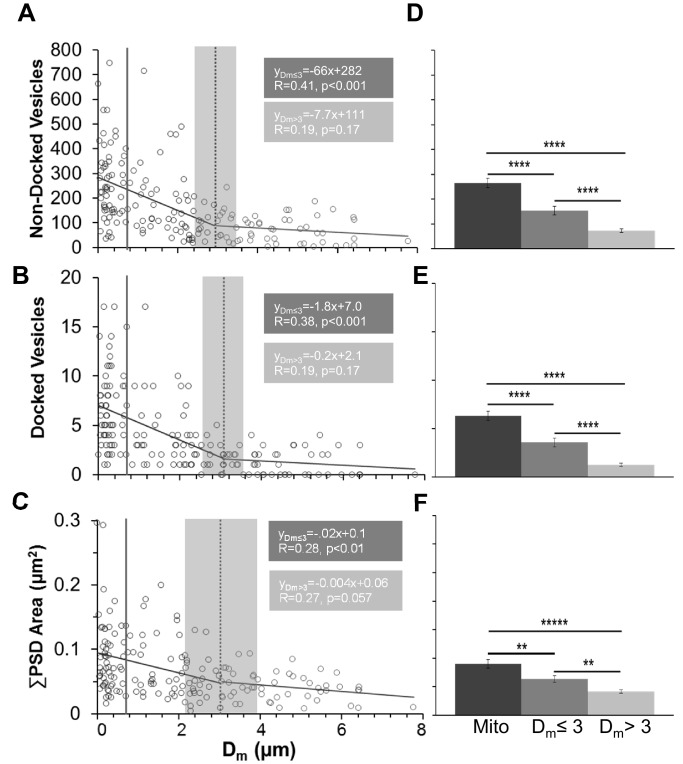
Synapses had fewer vesicles and PSD areas were smaller as distance from an axonal mitochondrion increased.(A) Nondocked vesicles versus mitochondrial distance (Dm) had a statistically significant breakpoint at 2.97 ± 0.67 µm (t(165) = 4.4, p<0.001). (B) The breakpoint for docked vesicles per PSD area versus mitochondrial distance was 3.06 ± 0.62 µm (t(161) = 4.92, p<0.001). (C) The breakpoint for PSD area per bouton (ΣPSD across MSBs) vs. Dm was 3.02 ± 1.24 µm (t(165) = 2.44,p=0.015). The mitochondria had lengths and hence were considered to be inside the bouton when any portion of the mitochondrion was within the vesicular domain and distances from the center of the PSD were shorter than the solid gray line positioned at 0.91 µm (in A–C), which was the longest measured distance from the edge of a PSD to a mitochondrion located within the vesicle cloud of a presynaptic bouton. Breakpoints in A–C are shown as mean (dashed line) ± s.e.m. (gray shading) from the regression analysis. (D) The mean number of nondocked vesicles was greater in boutons with a mitochondrion (mito) than at Dm ≤ 3 µm, which was greater than Dm > 3 µm (n = 177, F2,175 = 46.3, p<0.001). (E) The mean numbers of docked vesicles per PSD area was greater in boutons with a mitochondrion than at Dm ≤ 3 µm, which was greater than Dm > 3 µm (n = 183, F2,181 = 55.0, p<0.001). (F) The mean ∑PSD area was also greater when presynaptic boutons had a mitochondrion than when Dm ≤ 3 µm, which was greater than Dm > 3 µm (n = 175, F2,175 = 19.6, p<0.001). All these data are from perfusion-fixed hippocampus at P15. y-Axis labels in A–C are also for D–F, and similarly the x-axis labels at the bottom apply to all graphs above them. Significant post hoc differences are indicated as *p<0.05, **p<0.01, ***p<0.001, and ****p<0.0001.